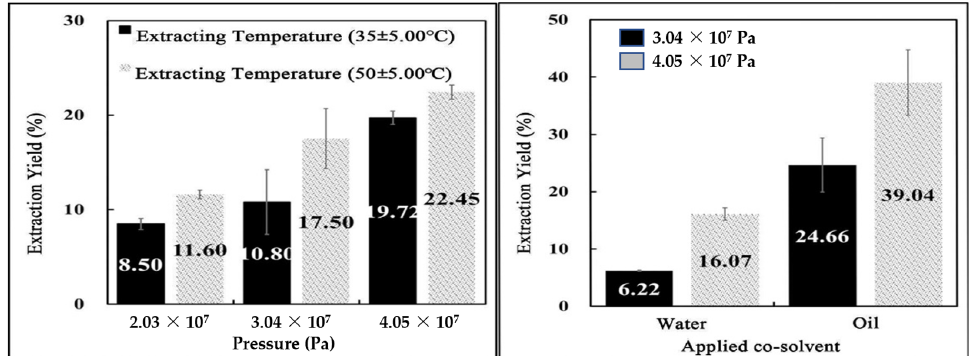
Figure 3. ( Left ) : The effect of extracting pressure on beef fat yield rate (%). The fat ingredient from beef samples extracted after supercritical extraction under different pressures (2.03 × 10 7 , 3.04 × 10 7 , and 4.05 × 10 7 Pa). Two different vessel temperatures were applied as 35 ± 5 ◦ C and 50 ± 5 ◦ C, ( Right ): The effect of co-solvent liquid on beef fat yield rate (%). The fat ingredient from beef samples extracted after supercritical extraction under the same temperature (50 ± 5 ◦ C) but different extracting pressures (3.04 × 10 7 and 4.05 × 10 7 Pa) and different co-solvents (vegetable oil and water). Visually, the beef sample’s color changed to a light brown color after SCF treatment in Figure 2d. The extraction efficiency depends on the type of co-solvents used, and according to the observations, vegetable oil is relatively more effective in extracting lipid than water as a co-solvent (Figure 3, right). SCF with water extracted 6.22 ± 0.10% with an extracting pressure of 3.04 × 10 7 Pa, and 16.07 ± 1.07% with an extracting pressure of 4.05 × 10 7 Pa. at 3.04 × 10 7 Pa, and 39.04 ± 5.71% at 4.05 × 10 7 Pa. Thus, SCF treatment with carbon higher lipid and fat loss yield. The experimental results in Figure 4c,d visually confirm